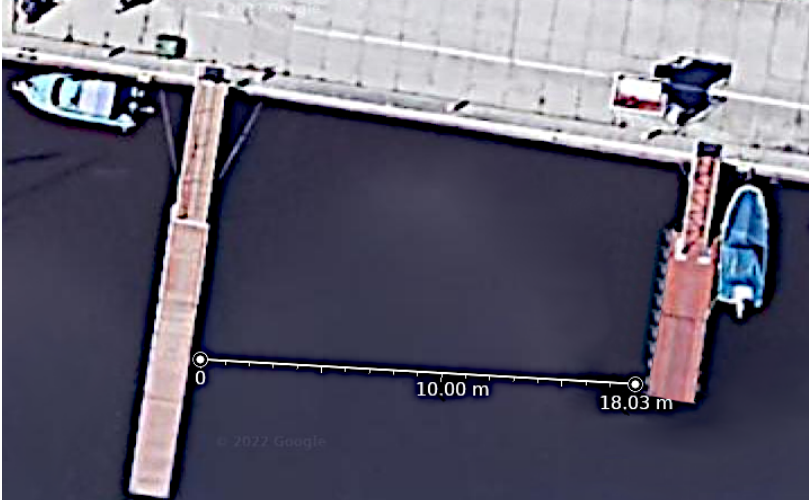
Figure 4. Map of the place of the experiment, taken from Google Maps. Coordinates: 51°08 (cid:48) 06.0 (cid:48)(cid:48) N 16°59 (cid:48) 57.9 (cid:48)(cid:48) E.